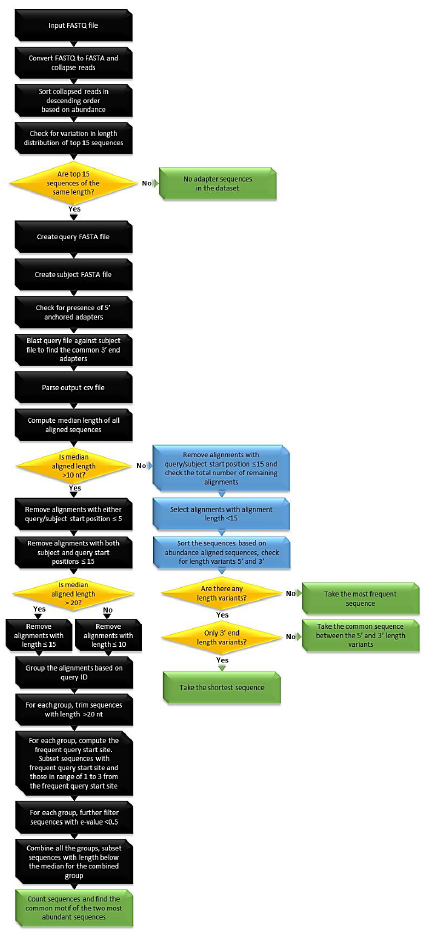
Figure 3. The adapt_find workflow. Black boxes: general procedure, green boxes: exit step, blue boxes: alternative strategy, yellow diamonds: decision.